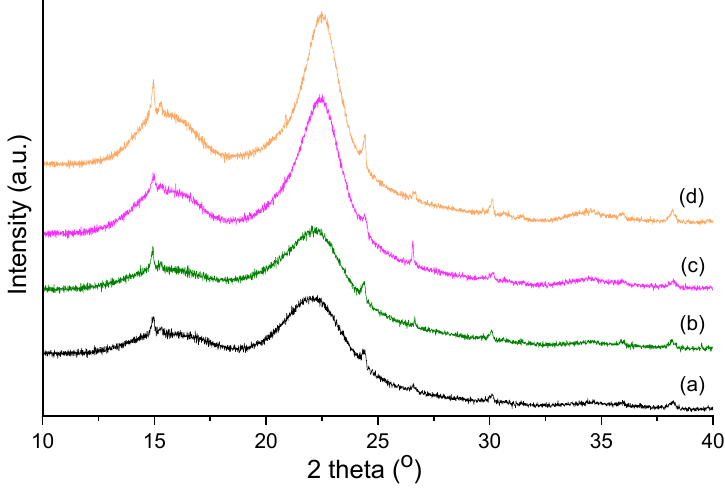
Figure 10. X-ray diffraction patterns of ( a ) raw material, ( b ) pretreated biomass at 160 °C for 30 min, ( c ) pretreated biomass at 180 °C for 30 min, and ( d ) pretreated biomass at 200 °C for 30 min .